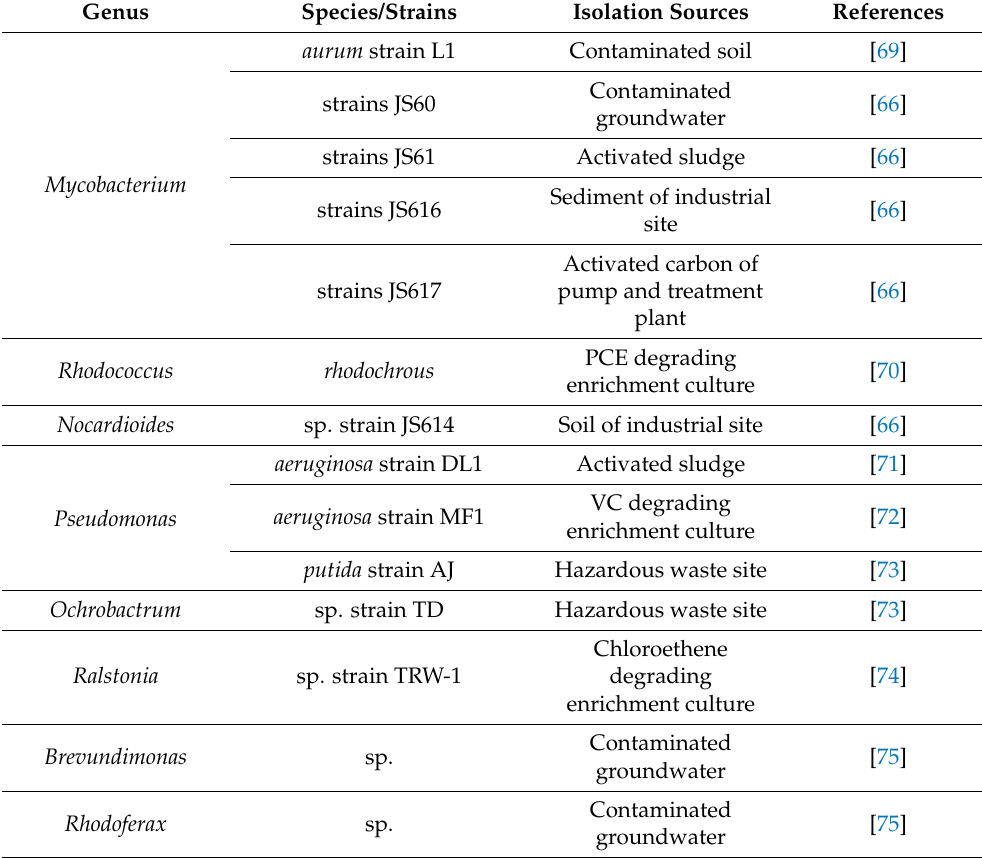
Table 2. Bacterial strains that are able to use VC as a carbon and energy source in aerobic